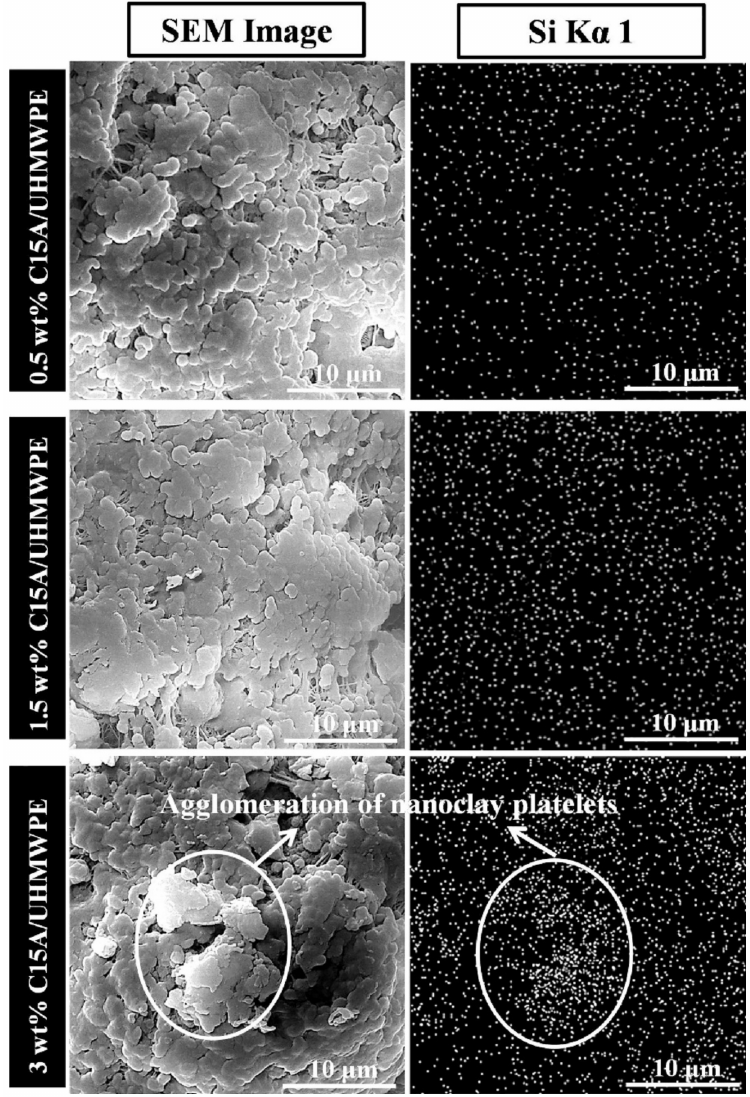
Figure 7. Scanning electron microscopic images of C15A/UHMWPE nanocomposites with 0.5, 1.5 and 3 wt.% loading, along with energy-dispersive X-ray spectroscopic elemental maps for silicon (Re- produced with permission from M. U. Azam, M. A. Samad, Progress in Organic Coatings; published by Elsevier, 2018)